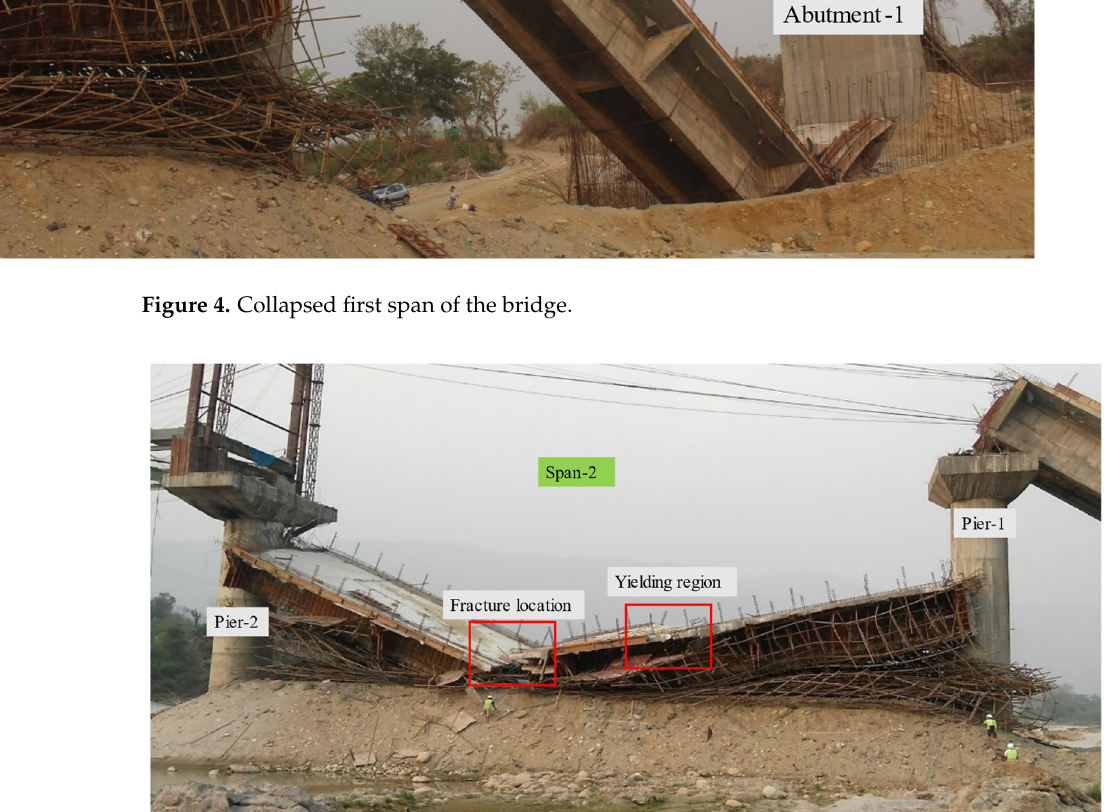
Figure 5. Destroyed second span of the bridge. The damaged props can be observed rested above loose sand and gravel.